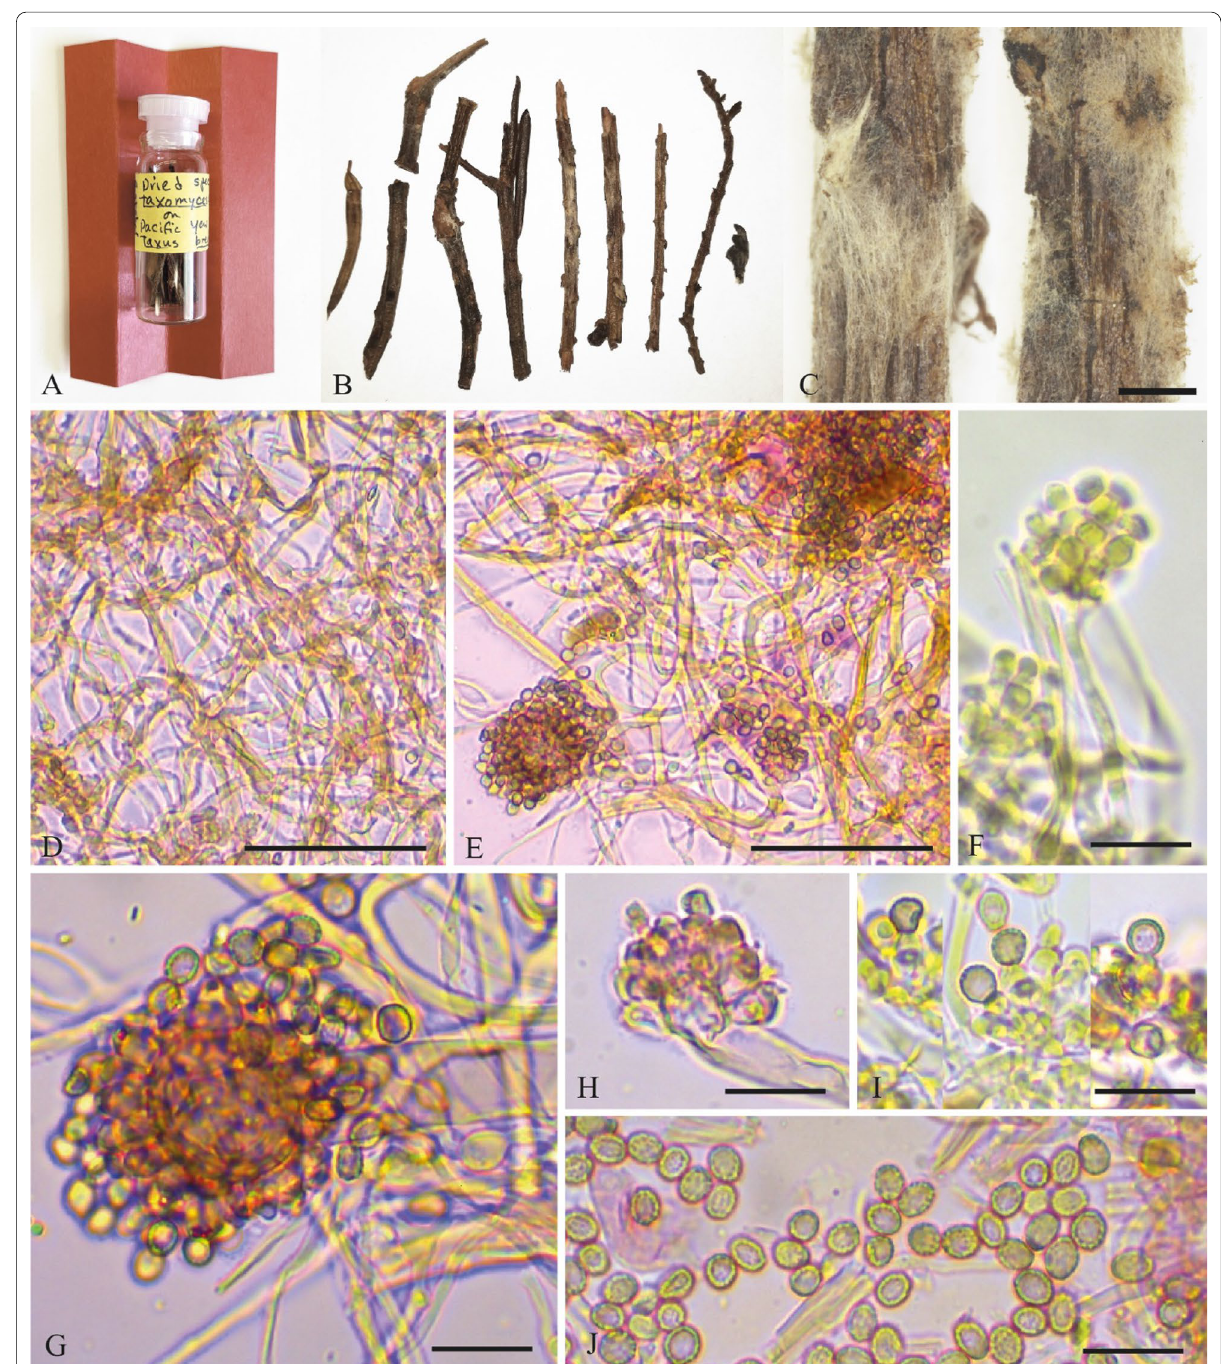
Fig. 3 Morphology of the type of Taxomyces andreanae . A – C : plant twigs; C-M microphotograps. Scales: C Reagents: KOH